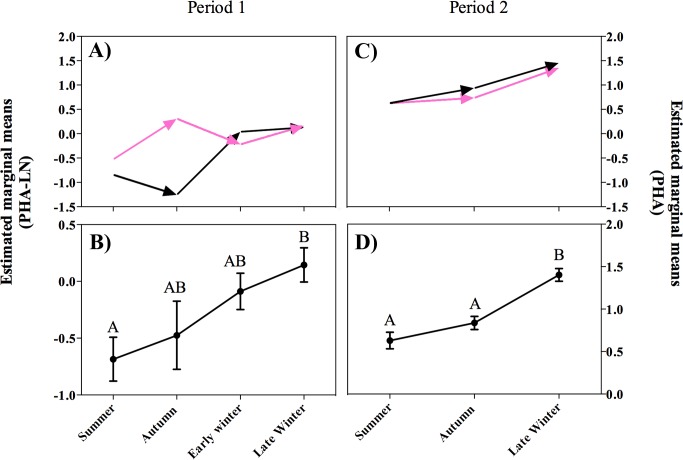
Seasonal swelling response after 24 hours of PHA injection.A) Data separated by sex from P1. B) Combined data from P1 (estimated marginal mean ± SE). C) Data separated by sex from P2. Pink arrows represent seasonal variation in the swelling response in females; black arrows represent seasonal changes in swelling response in males; D) Combined data from P2 (estimated marginal mean ± SE); different letters indicate significant differences among seasons.